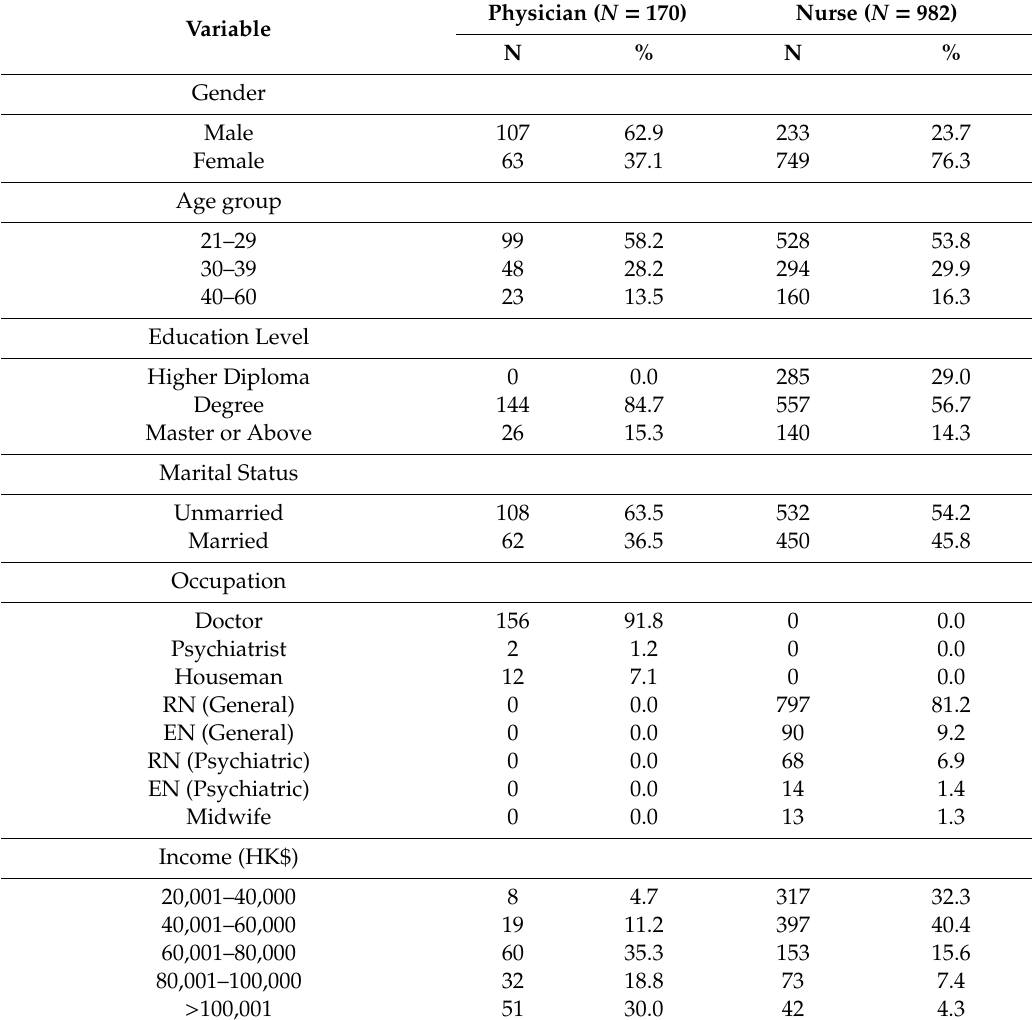
Table 1. Frequency distributions of the background variables ( N =